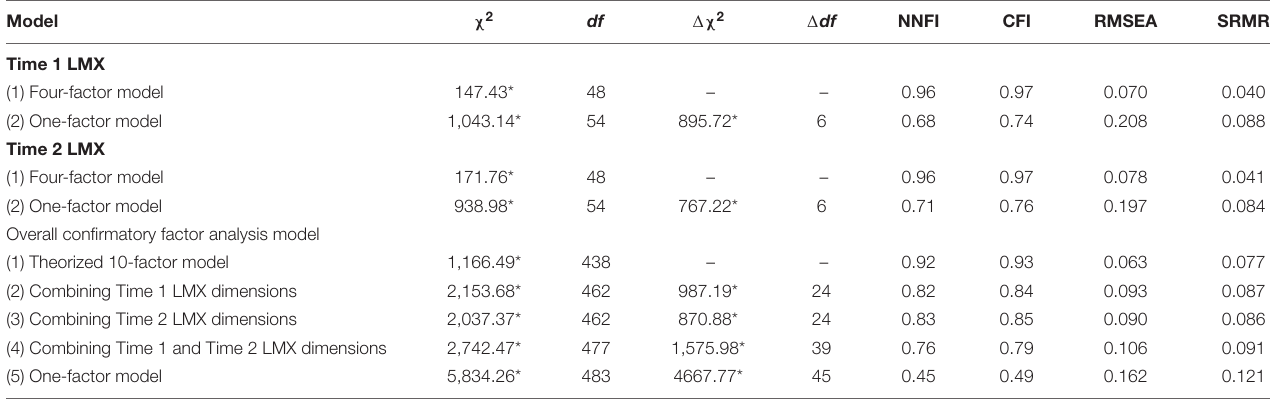
TABLE 1 | Fit indices for confirmatory factor analysis models. Model χ